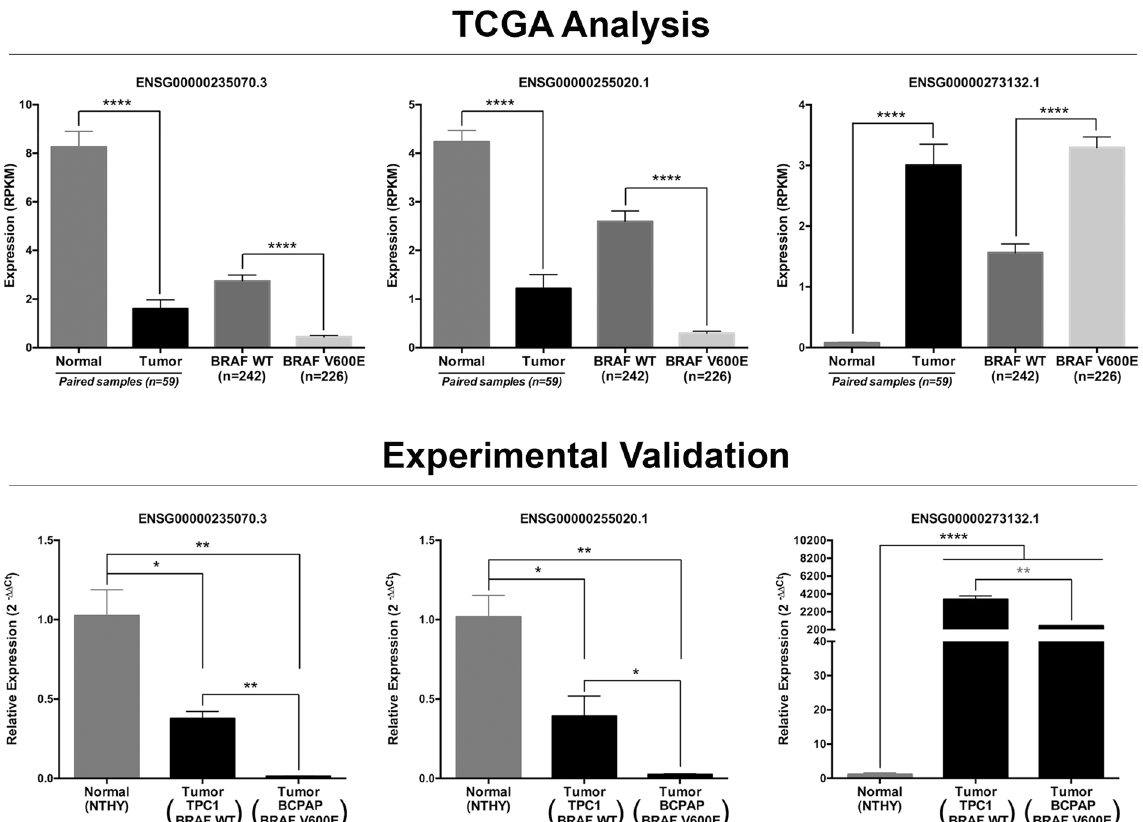
Figure 2. Experimental validation of DE lncRNAs. Upper part of panel displays the expression levels of the indicated lncRNAs in the TCGA analyses. The nonparametric Mann–Whitney test was applied due to the non-Gaussian expression distribution and p-value was assigned. Lower part of panel displays the experimental validation of these lncRNAs measured by qRT-PCR and calculated with 2 −ΔΔ Ct method using RPL19 (Ribosomal Protein L19) as endogenous control. Experiments with three biological replicates were performed using two technical replicates for each sample. These results are representative of at least two independent experiments. Values are plotted as expression mean ± Standard Error of Mean (SEM). Unpaired two-tailed t-Test assigned the